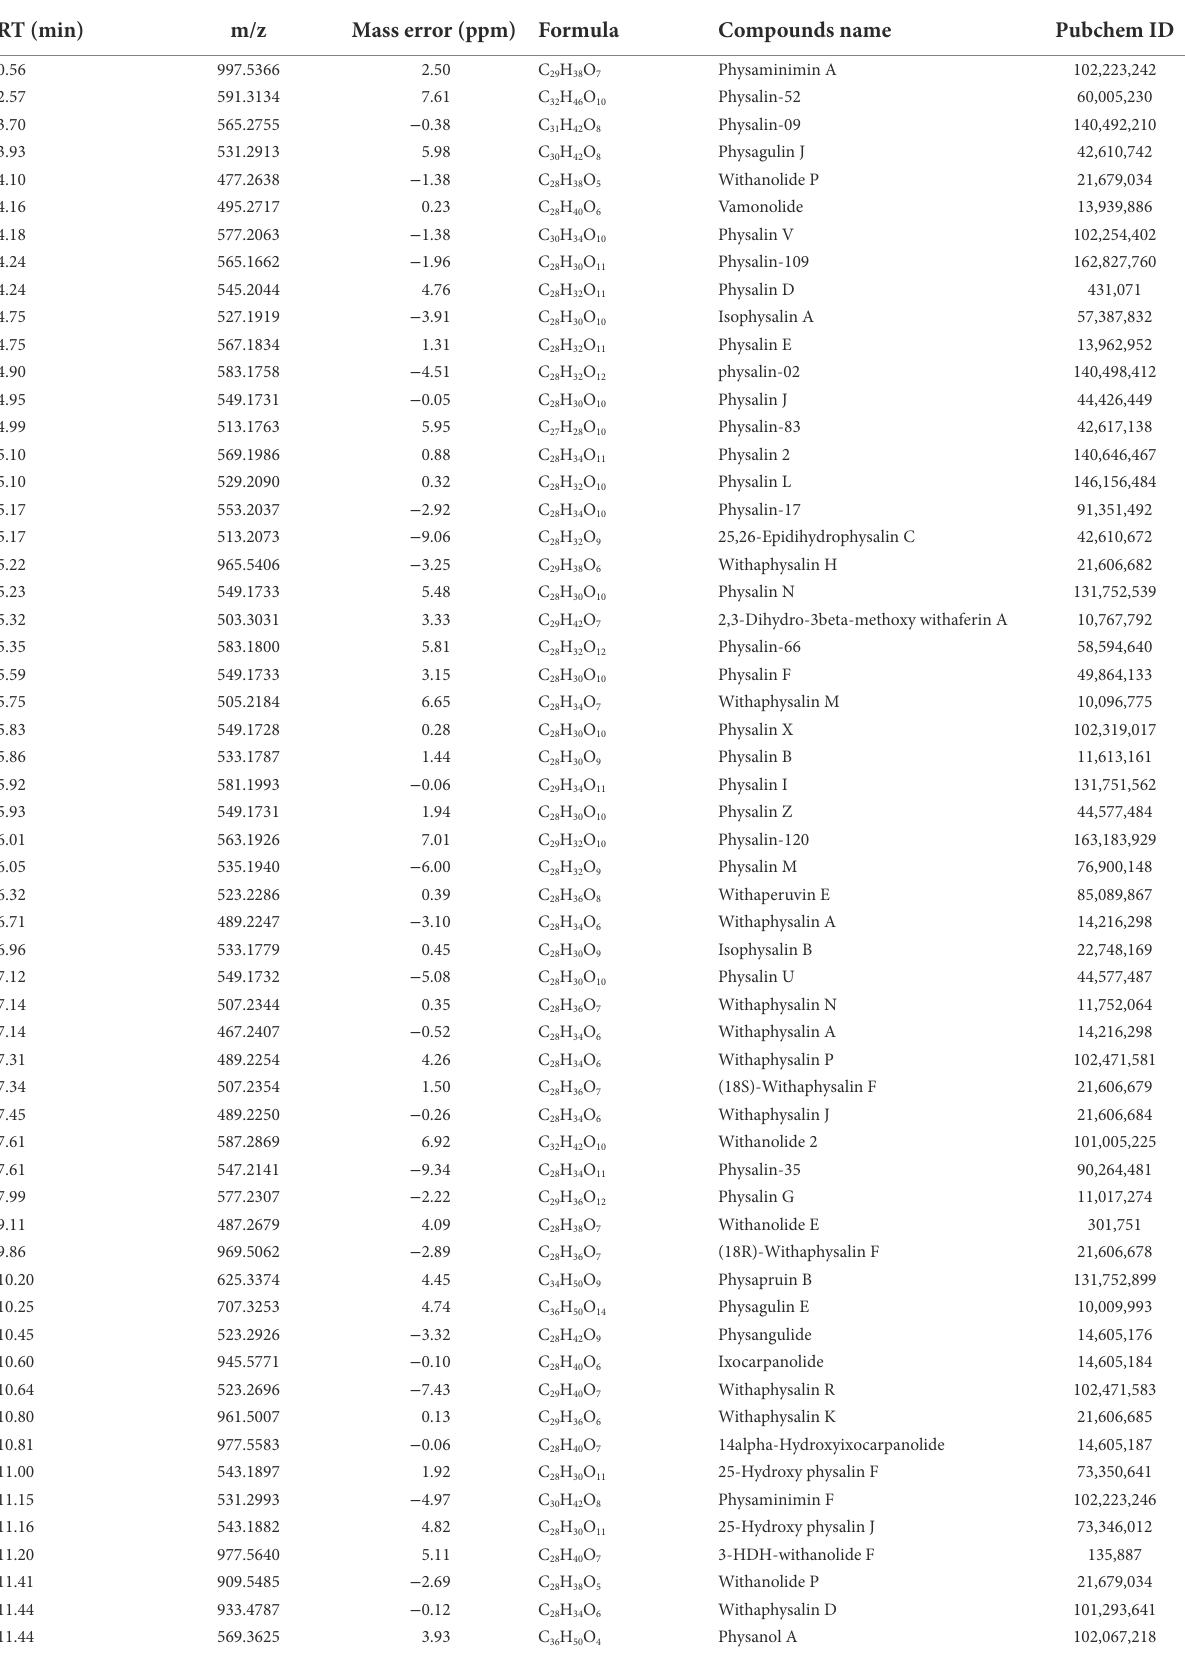
TABLE 2 Summary of the physalins metabolites identification